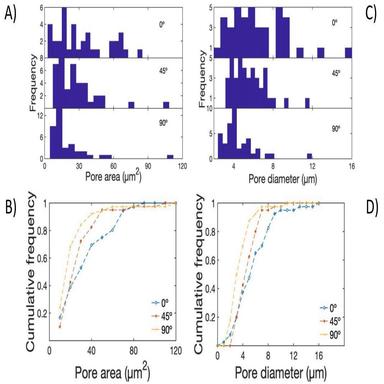
Histograms representing A) pore areas and C) diameters for the 0◦, 45◦ and 90◦ specimens in the as-built condition. And the cumulative frequency, normalised to the unity, of the B) pore area and D) diameters in the samples.